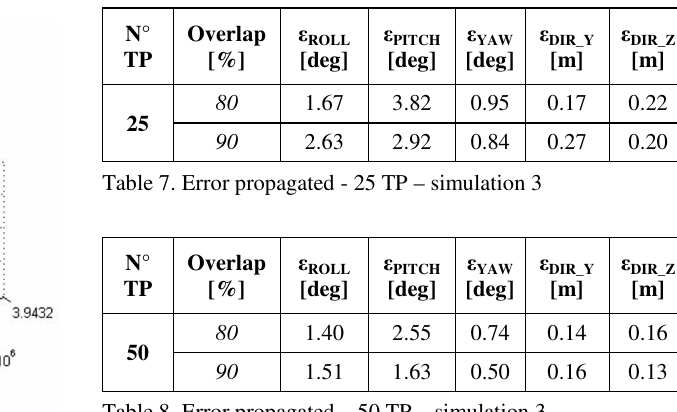
Figure 8. Example of quasi-random object points distribution (blue) and curvilinear trajectory (red)